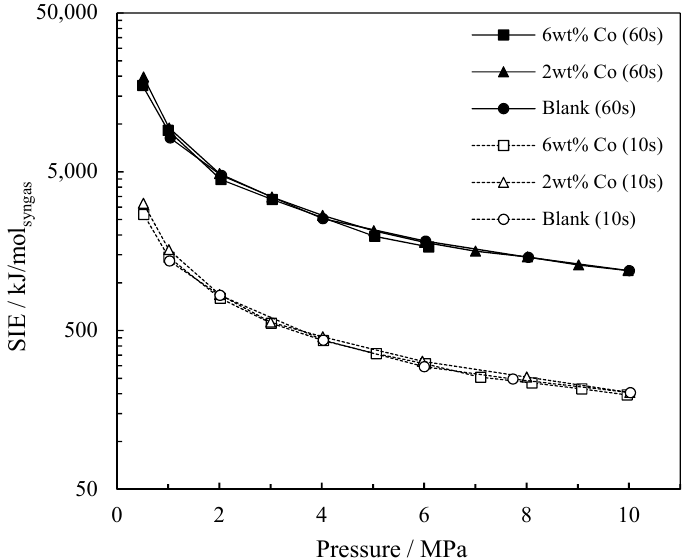
Figure 5. Specific input energy (kJ/molsyngas) as a function of pressure for plasma-catalytic FTS (NTP + Blank, 2 or 6 wt% Co catalyst) at discharge times of 10 and 60 s. Legend: ■ —6 wt% Co (60